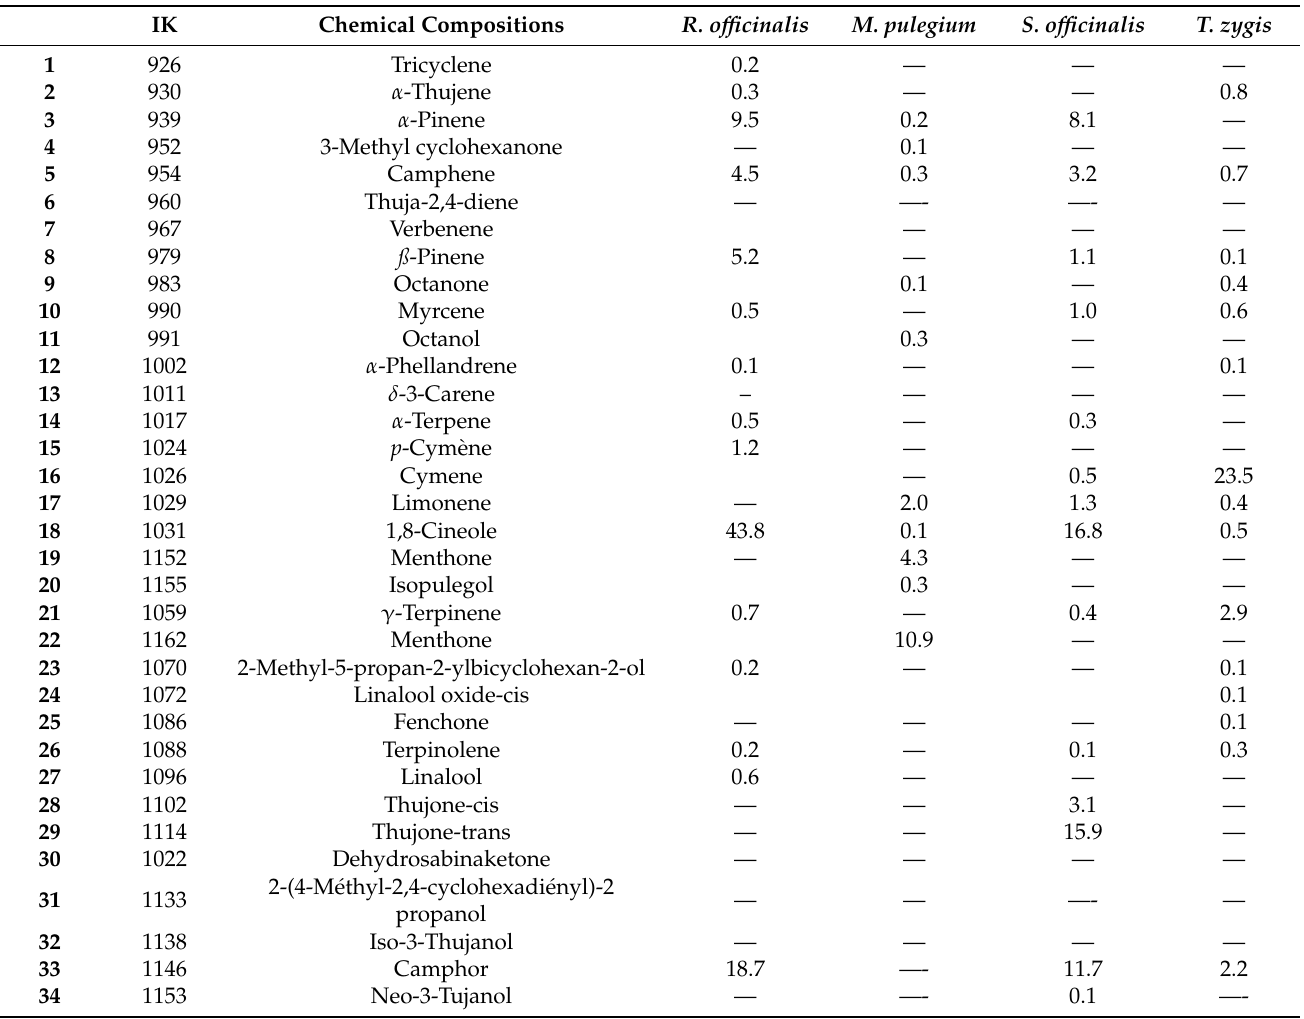
Table 2. Chemical composition of R. officinalis , M. pulegium , S. officinalis, and T. zygis